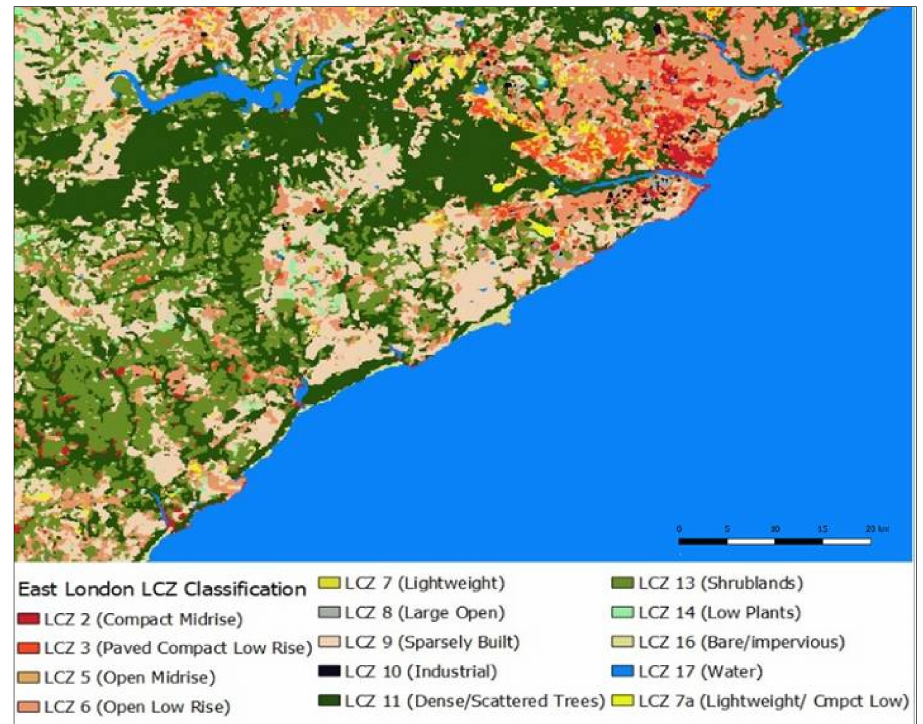
Figure 14. East London classification output for multitemporal with neighborhood function using local customized